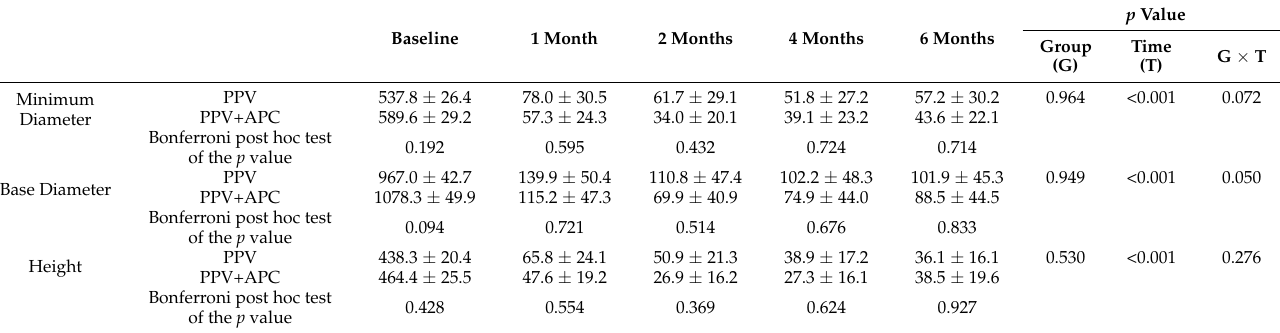
Figure 2. Representative cases showing preoperative and postoperative OCT images. Left row shows preoperative OCT, middle row shows OCT taken 1 month after surgery, and right row shows OCT taken 6 months after surgery. ( A – C ) OCT images of a 68-year-old woman with large MH (minimum hole diameter 531 um) (PPV+APC group). ( D – F ) OCT images of a 75-year-old man with MH with high myopia (axial length 25.56 um) (PPV+APC group). ( G – I ) OCT images of a 66-year-old woman with large MH (minimum hole diameter 564 um) (PPV group). Inverted ILM flap technique was used during surgery. ( J – L ) OCT images of a 69-year-old woman with large and persistent MH after primary surgery (PPV+APC group). Table 3. Comparison of macular hole size between the two